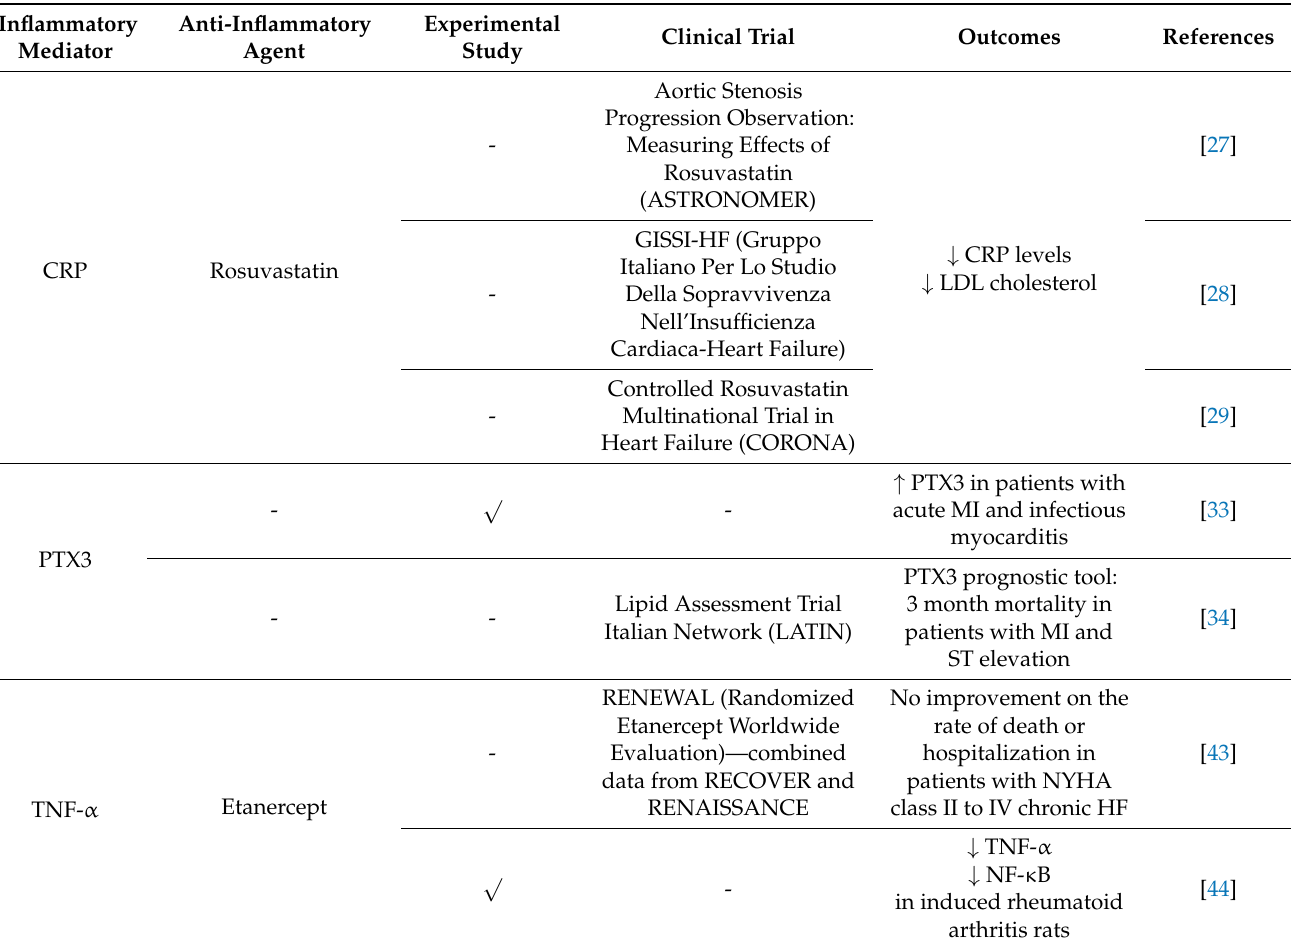
Table 1. Experimental studies/ clinical trials targeting inflammatory mediators in cardiovascular